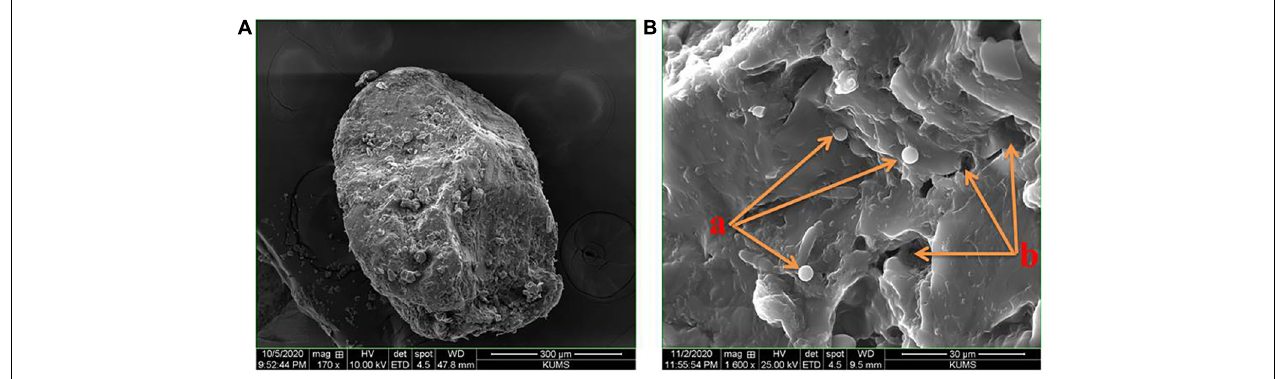
FIGURE 1 | Morphological images of T34 probiotic drop with Tarkhineh texture by the scanning electron microscopy (Hitachi SU3800): (A) elliptical shape probiotic drop and their protective layers for the probiotic cells, (B) : (a) network-like structures of Tarkhineh texture and entrapped probiotic cells and (b) tiny pores on the surface of Tarkhineh texture.